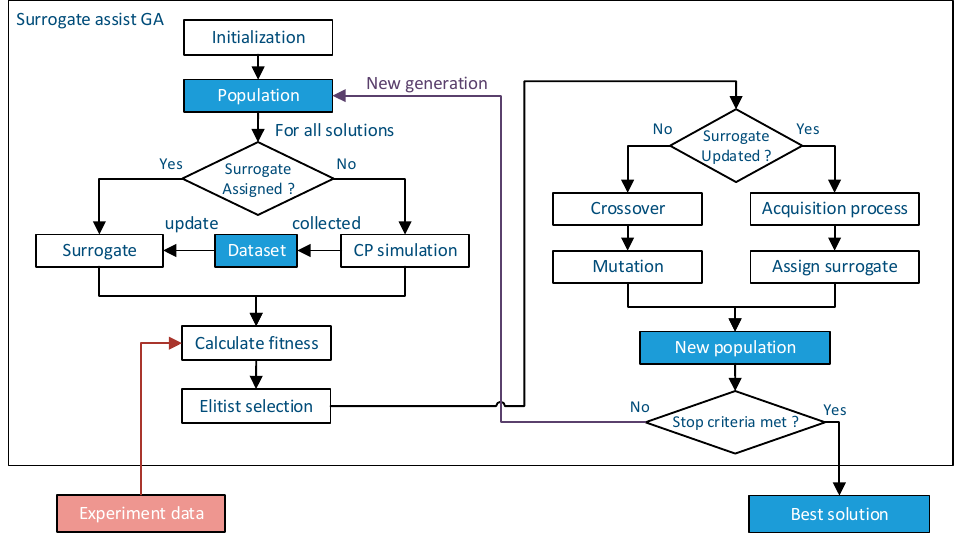
Figure 1. Workflow of CP parameter calibration using SGA.